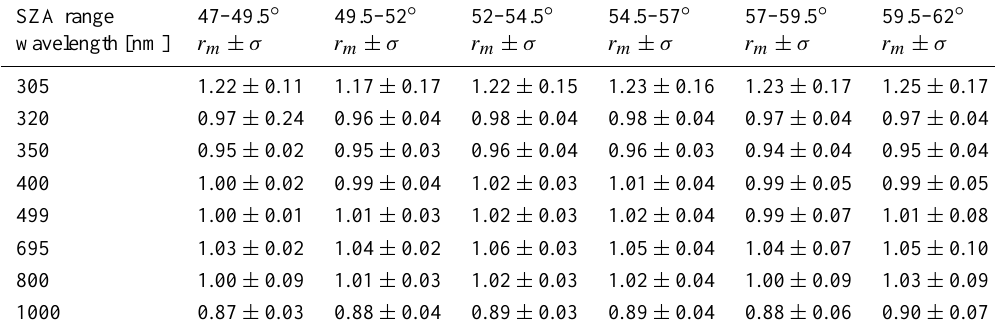
Table 1. Agreement between measured and modelled spectra of downwelling irradiance for small ranges of SZA. Listed are only specific wavelengths. The mean ratio r m between measurement and model, as well as the standard deviation σ , is